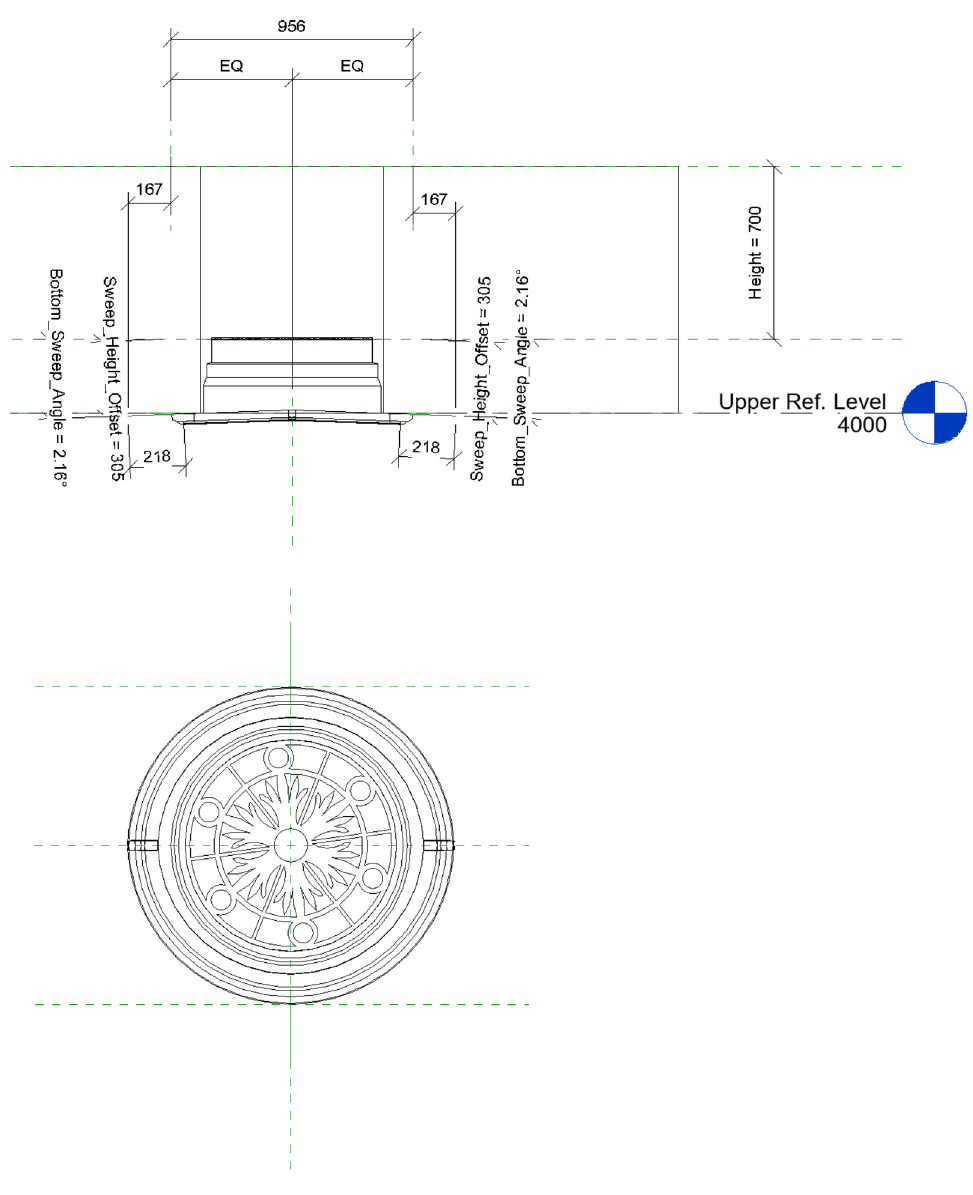
Figure 7. Possil Park Library Ventilation grille parametric family.